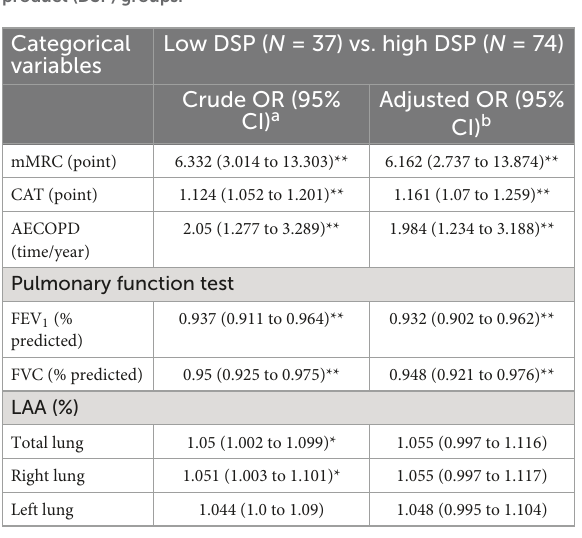
TABLE 2 Associations (odds ratios, ORs) of details of life quality, dyspnea sensation level, acute exacerbation frequency, pulmonary function test measurements, and low-attenuation area percentage (LAA%) between the low- and high-distance-saturation product (DSP)